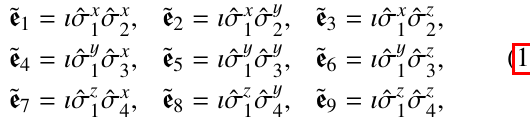
-tree with L = 3 L